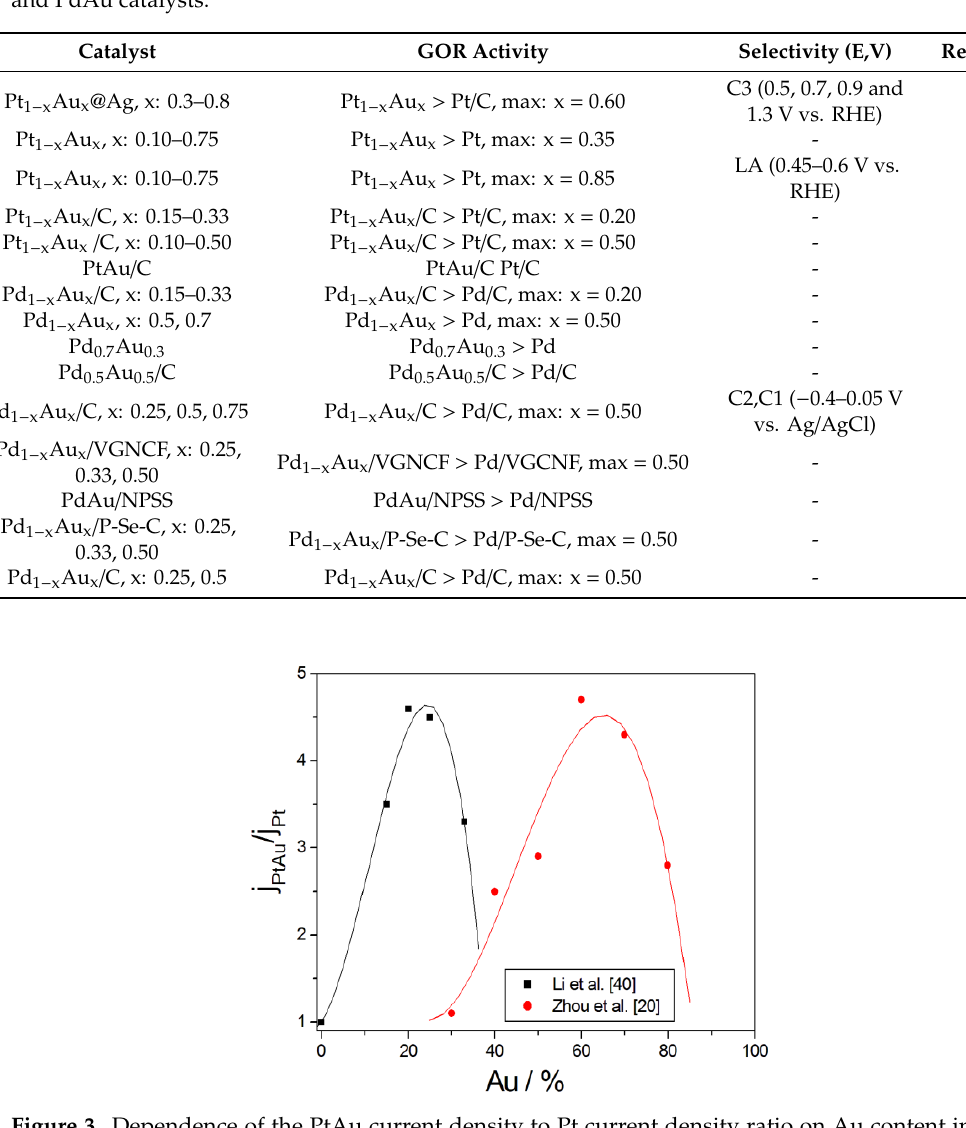
Figure 3. Dependence of the PtAu current density to Pt current density ratio on Au content in the catalyst for datasets from Li et al. [40] and Zhou et al. [20].